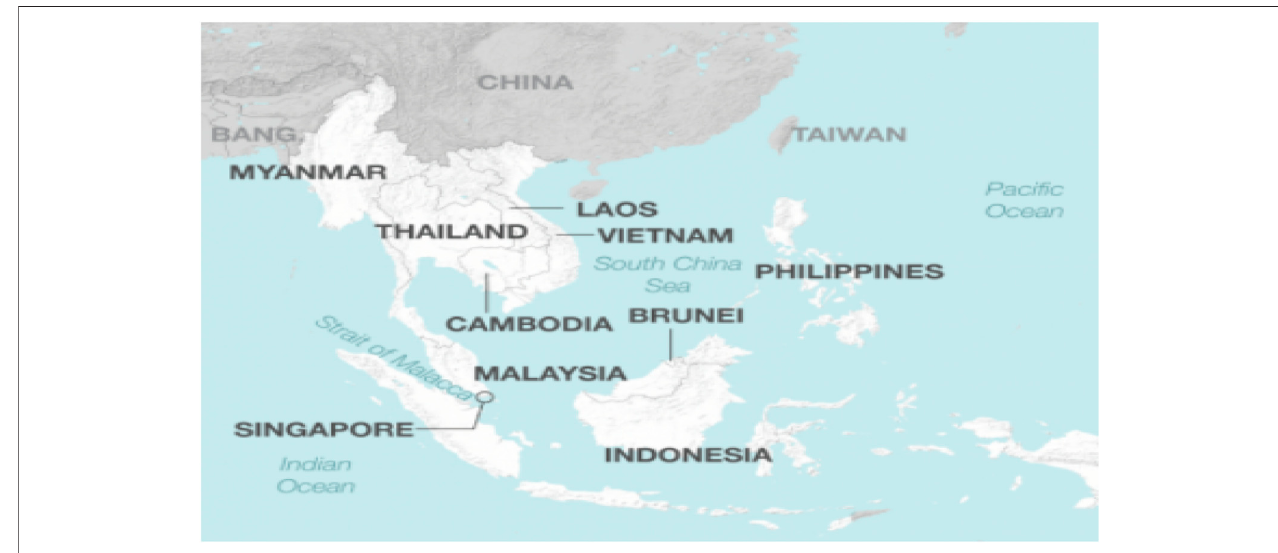
FIGURE 1 | Geographical importance of ASEAN. Source: Stratfor